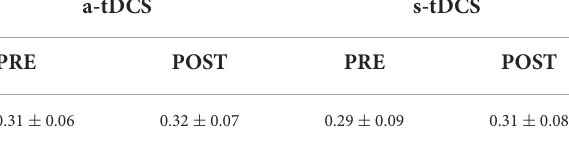
TABLE 1 Short latency afferent inhibition (SAI), expressed as a ratio of the amplitude of the conditioned MEPs respect to that of the mean ), collected before and after unconditioned response (SAI = COND TEST anodal transcranial direct current stimulation (a-tDCS) or sham (s-tDCS) over M1. a-tDCS s-tDCS PRE POST PRE POST 0.31 ± 0.06 0.32 ± 0.07 0.29 ± 0.09 0.31 ± 0.08 Mean ±